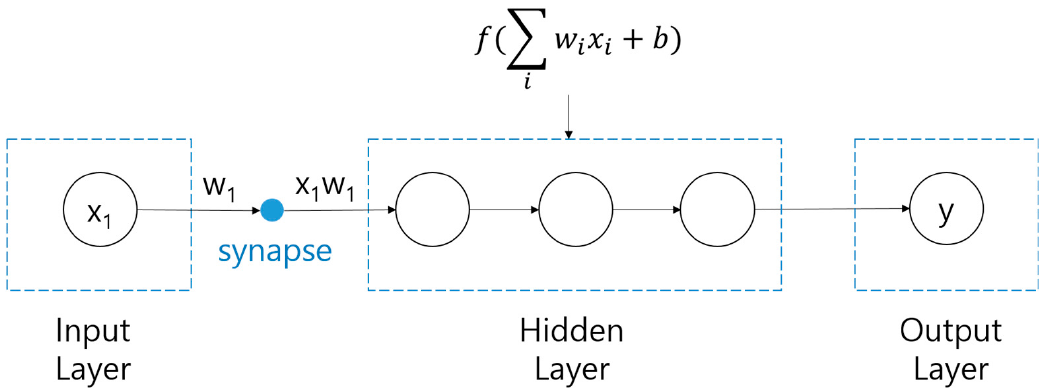
Figure 6. Schematic representation of DNN algorithm.